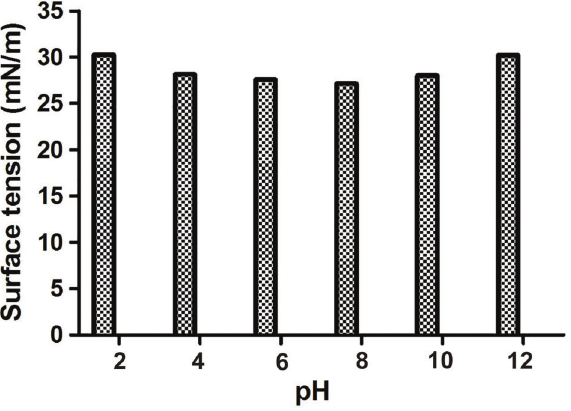
Figure 5. In fl uence of temperature on the surface tension of the biosurfactant after 96 h of